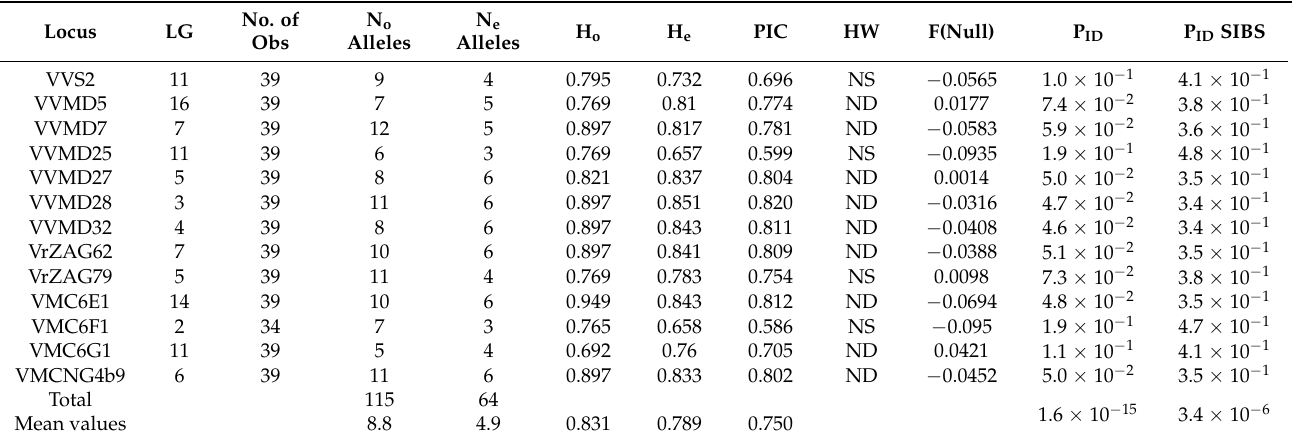
Table 3. Statistics on the 13 SSR markers